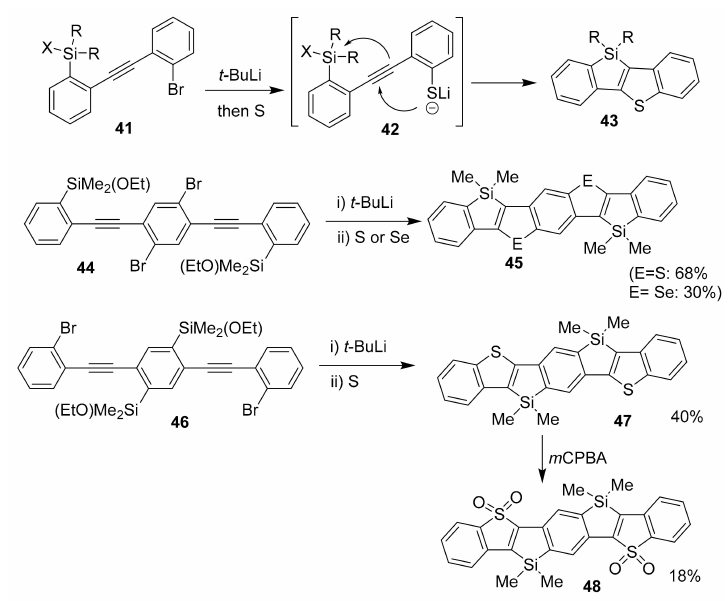
Scheme 7. Synthesis of ladder